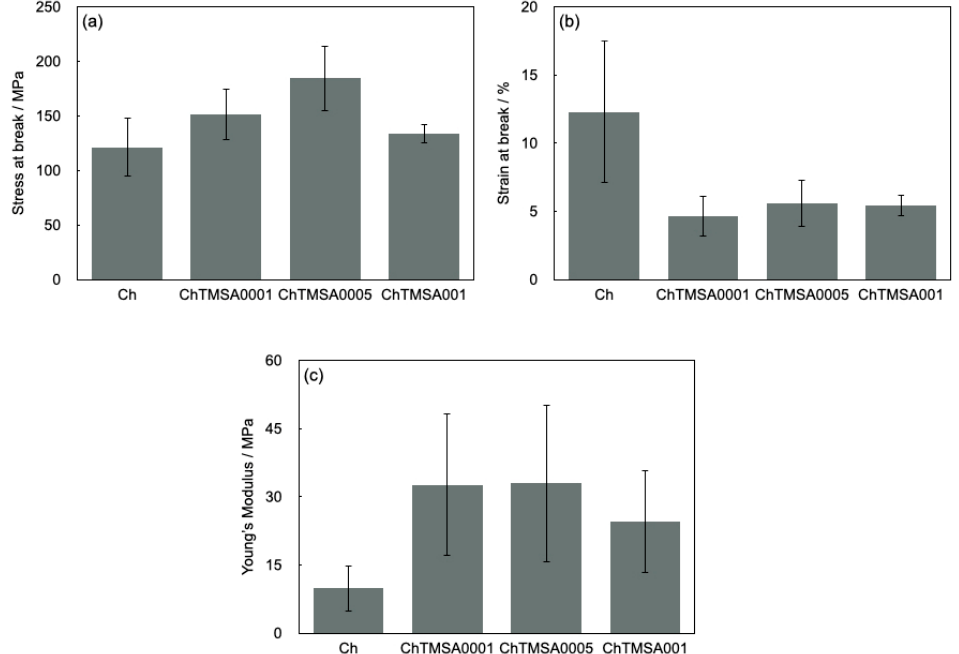
Figure 8. Stress–strain curves of the chitosan − TMSA microfibers.